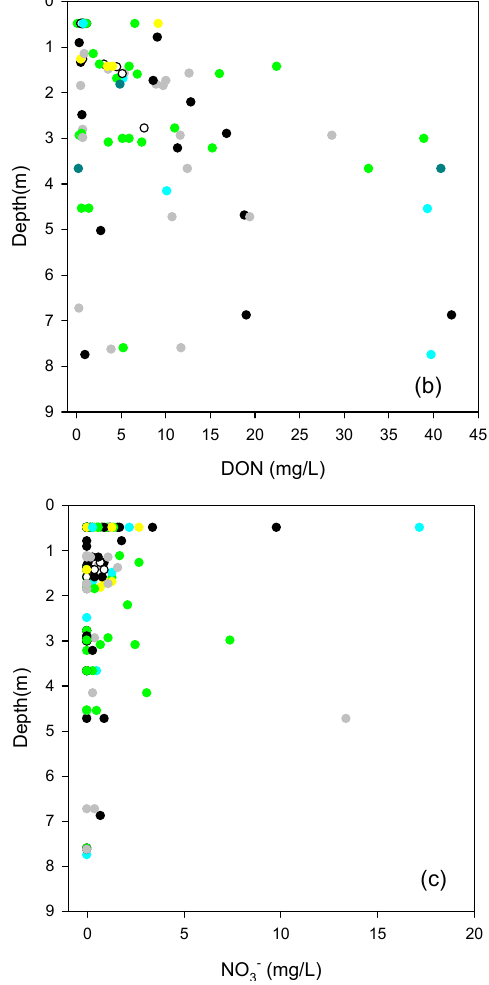
Figure 10. Distribution of major nitrogen species concentrations with depth at ML for individual samples, ( a ) NH4 + , ( b ) DON and ( c ) NO 3 − . Wetland terrain units are colour-coded. Upland is shown in yellow.